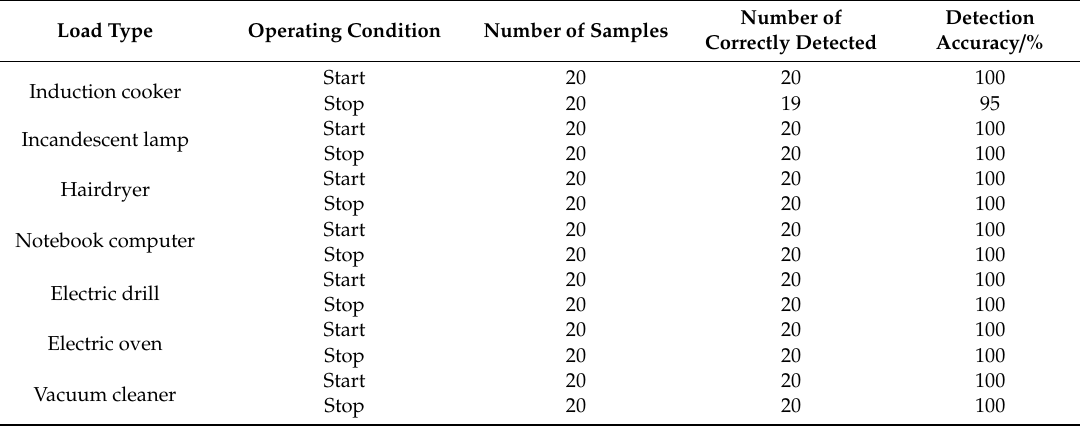
Table 6. Detection results of